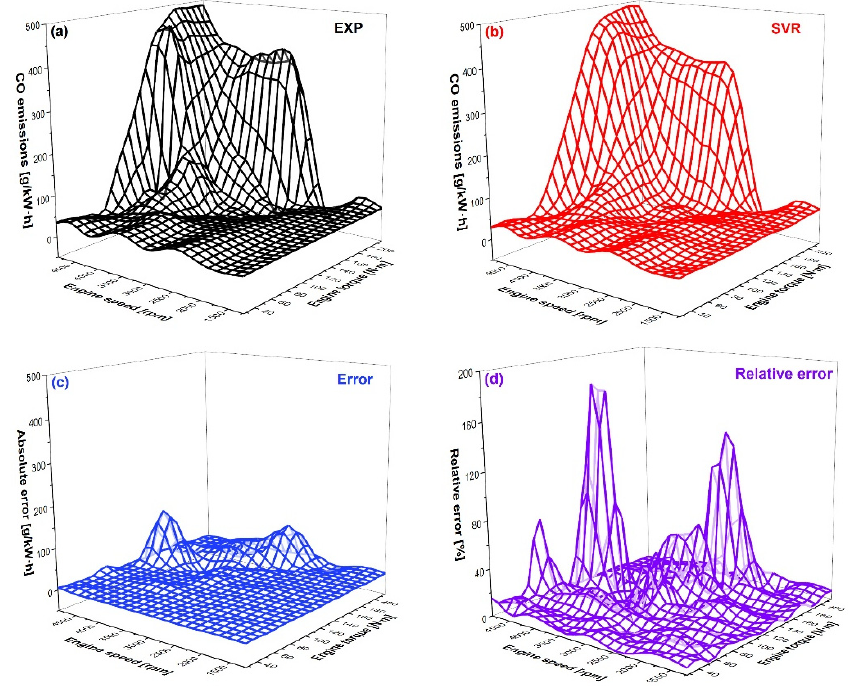
Figure 13. Comparison of SVR-predicted and experimental CO-emissions-established engine map.